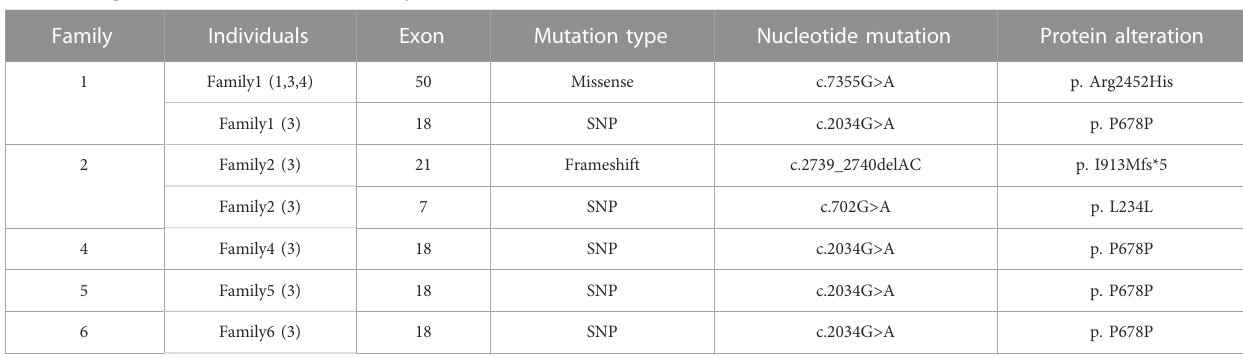
TABLE 1 NF1 gene mutations detected in this study. Family Individuals Exon Mutation type Nucleotide mutation Protein